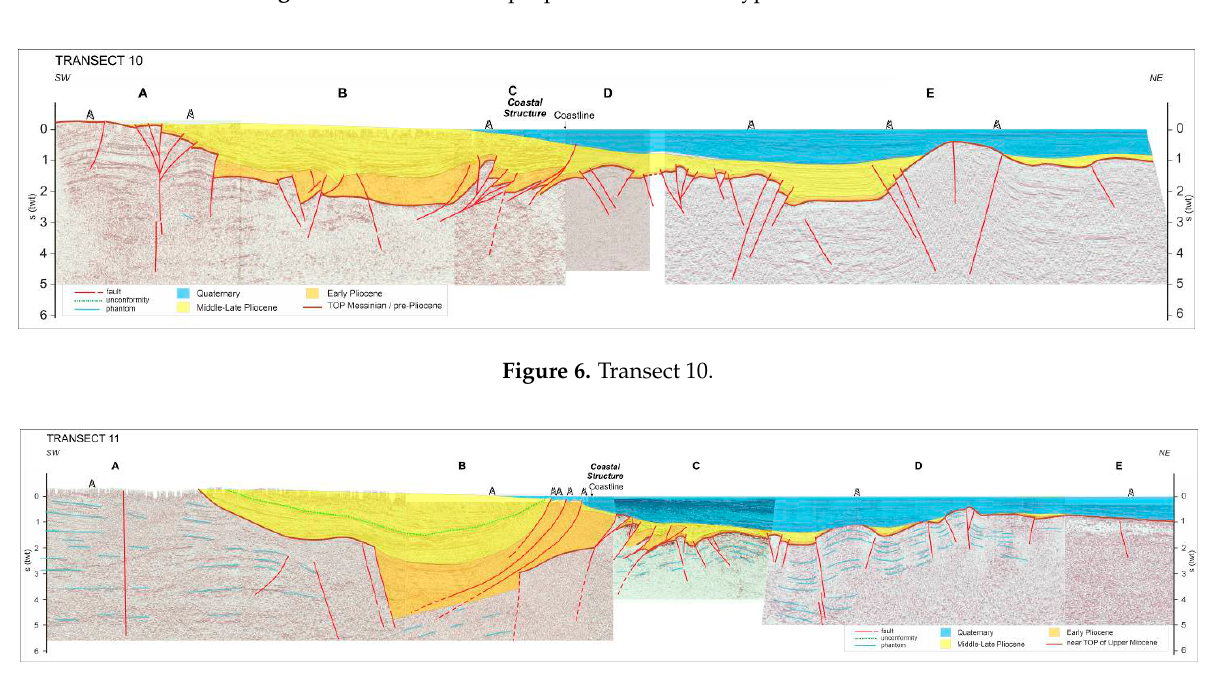
Figure 8. Transect 12.